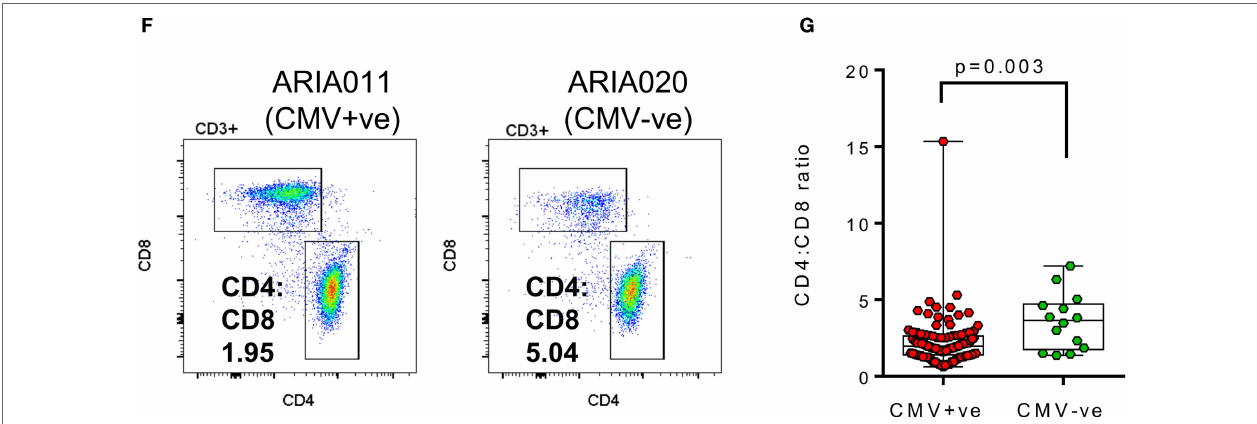
FigUre 2 | Impact of human cytomegalovirus (HCMV) carriage on T cell numbers. EDTA treated whole blood was stained with a panel of phenotyping antibodies in order to enumerate CD4 + and CD8 + T cells and their subsets. Representative dot plots from a HCMV seropositive (HCMV + ve) and HCMV seronegative (HCMV-ve) age-matched donors are illustrated showing the memory (as defined by CD27 and CD45RA expression) and differentiation level (as defined by CD27 and CD28) phenotype of both CD4 + and CD8 + T cells; the number of cells per microliter of whole blood for effector memory (T EM —CD27 − CD45RA − ) CD4 + and CD8 + T cells and Intermediate (INT—CD27 − CD28 + ) and Late (LATE—CD27 − CD28 − ) differentiated CD8 + T cells are shown (a) . Box and whisker plots comparing cell numbers of the memory (B,D) and differentiation phenotypes (c,e) of CD8 + T cells and CD4 + T cells, respectively, between HCMV + ve (red) and HCMV-ve (green) donors are shown. The differences between the two groups were analyzed by a Kruskal–Wallis one-way ANOVA test with post hoc Mann–Whitney U -test performed with significant results set as p ≤ 0.015 shown on each graph. A representative CD4 vs CD8 dot plot from the same donors with their respective CD4:CD8 ratio indicated are shown (F) , the comparison of CD4:CD8 ratios for all seropositive vs seronegative donors are also shown (g) with the significant decrease in the CD4:CD8 ratio in HCMV positive donors indicated (Mann–Whitney